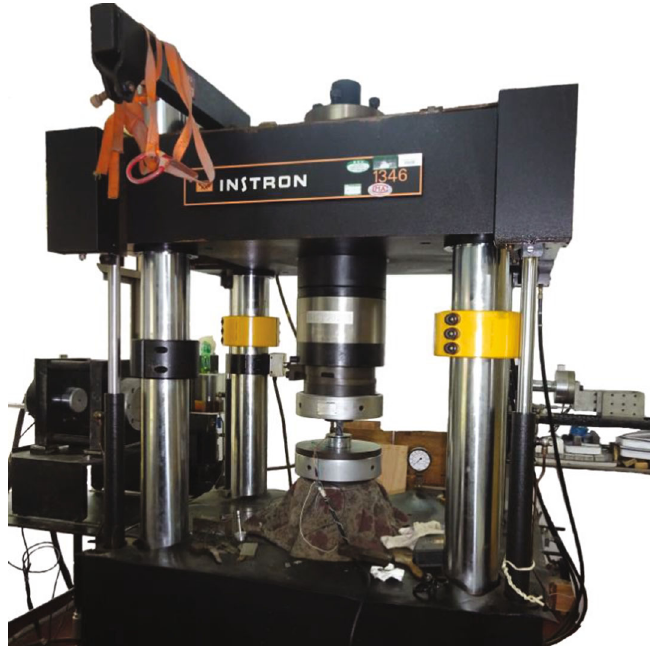
Figure 7: INSTRON 1346 electrohydraulic servo-controlled material testing machine (from Wang et al.